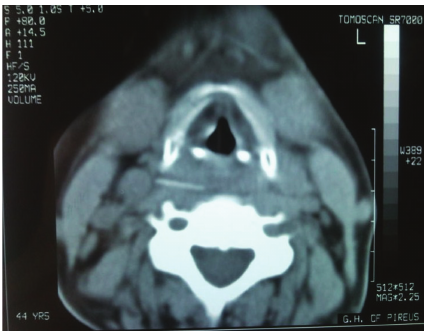
Figure 1: CT Imaging revealed the foreign body impacted in the prevertebral space.